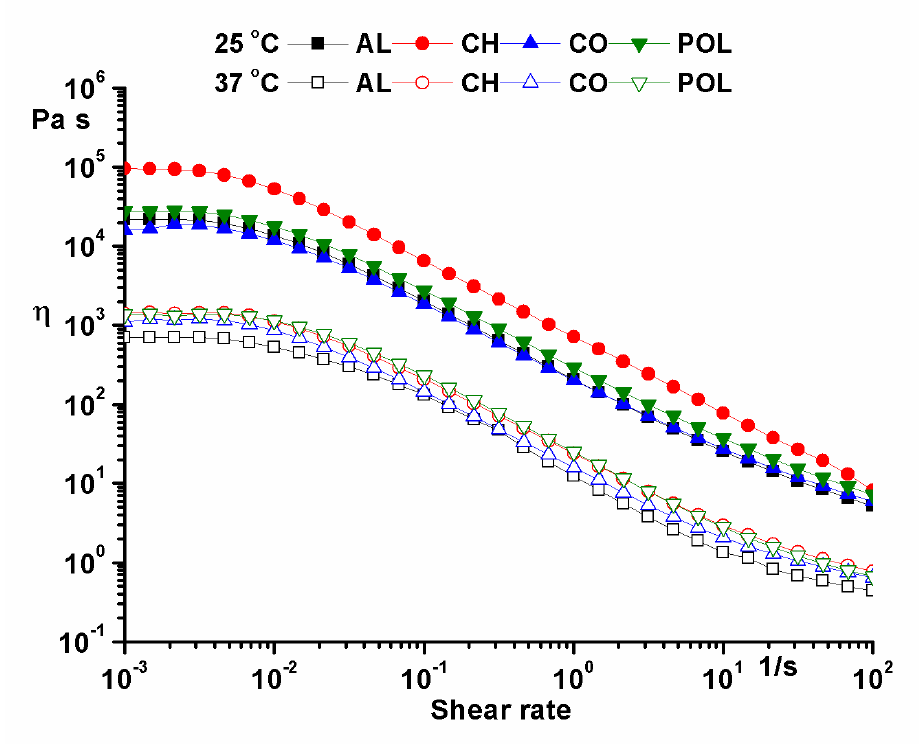
Figure 4. Temperature test in oscillation mode. Figure 4. Flow curves at 25 °C (full symbols) and 37 °C (empty symbols). Table 1. The values of zero shear viscosity (Carreau-Yasuda